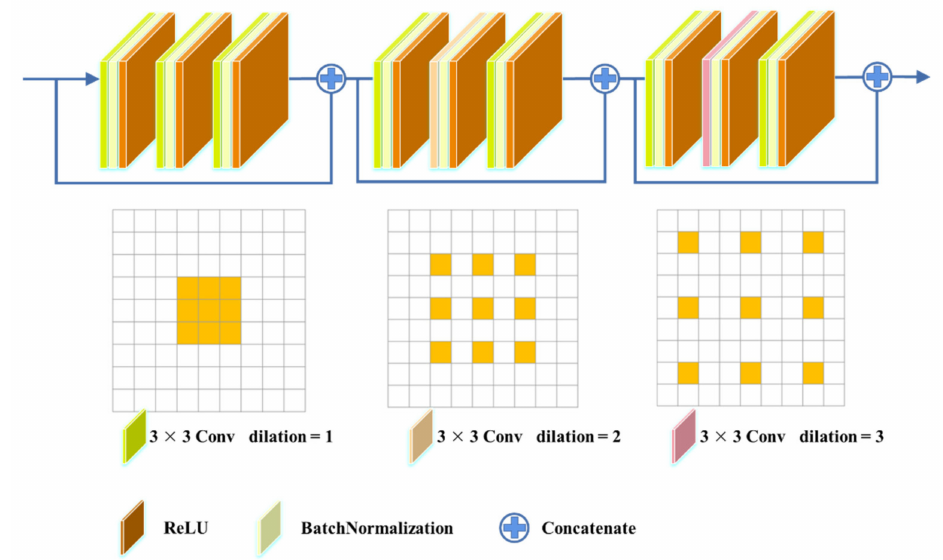
Figure 4. Structure of the ResHDC block. Every three adjacent convolution layers in the structure are a group, and the features input to each group of modules and the features output from the group are